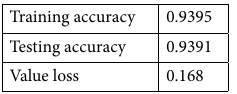
Table 2. Results of